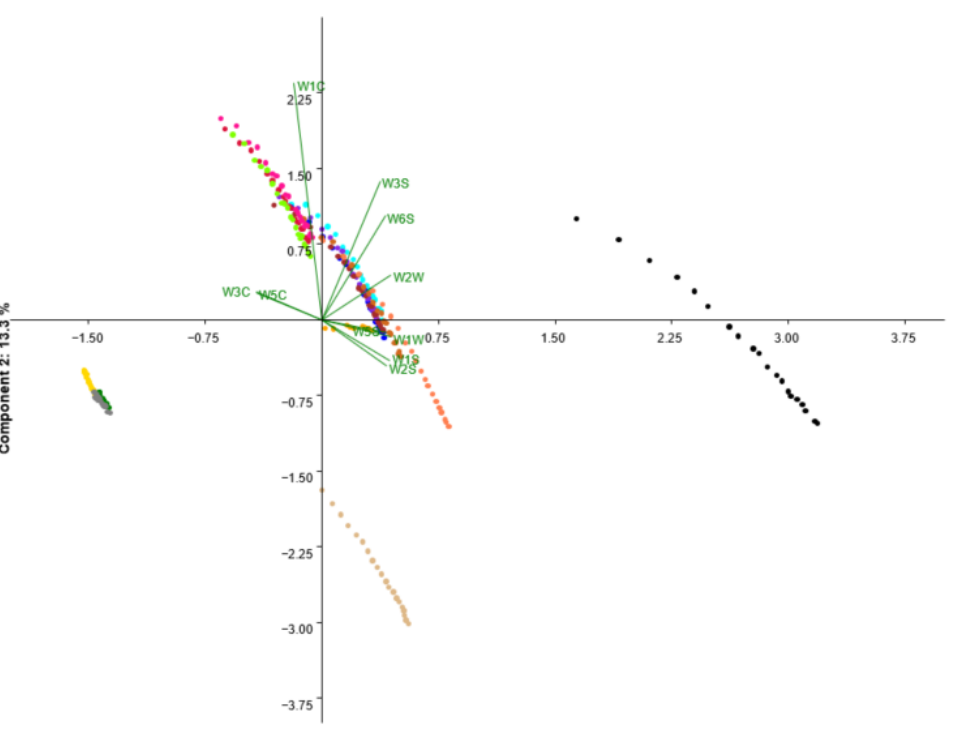
sample; orange dots, peeled wood; red dots, sliced wood; green dots, wood tablets.